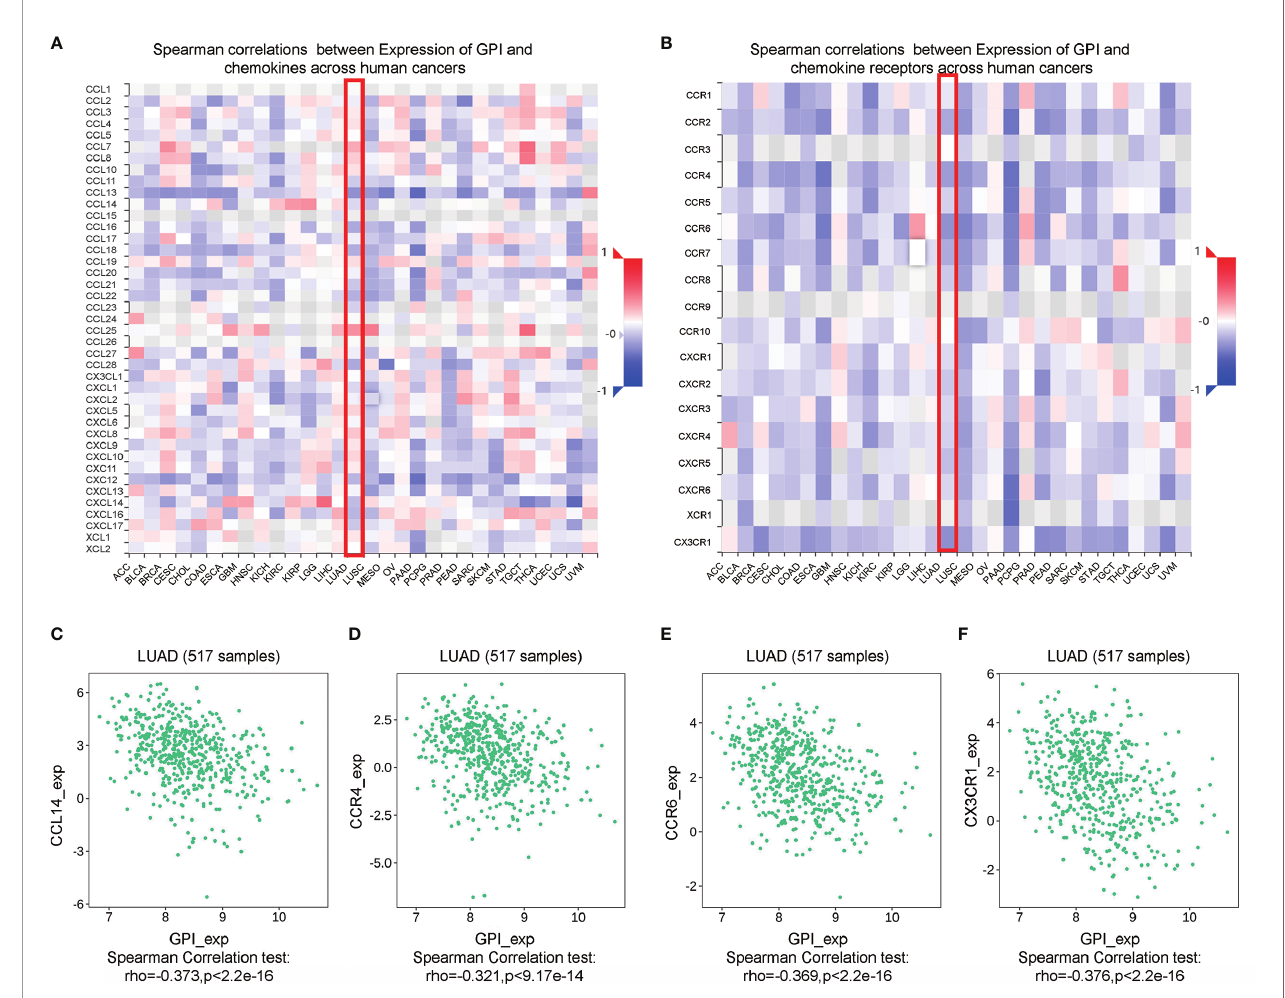
FIGURE 12 | Correlation analysis between glucose-6-phosphate isomerase (GPI) expression and chemokines and/or chemokine receptors. (A) Heatmap analysis of the correlation between GPI and chemokines in tumors. (B) Heatmap analysis of the correlation between GPI and chemokine receptors in tumors. (C – F) GPI expression in lung adenocarcinoma (LUAD) is negatively correlated with CCL14, CCR4, CCR6, and